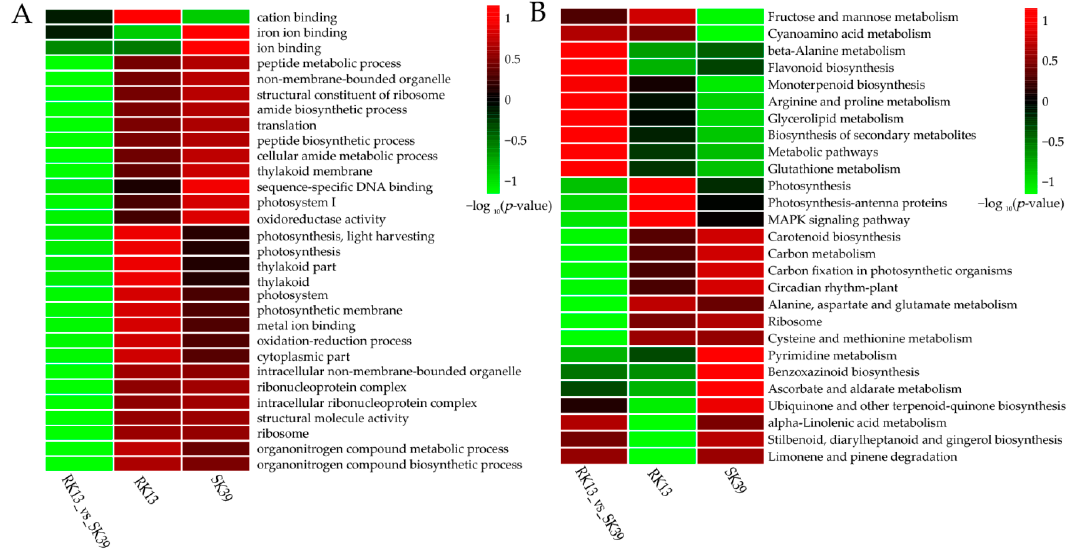
Figure 3. Functional classification of DEGs. Heatmaps of the Top 30 GO terms ( A ) and the Top 30 KEGG pathways ( B ) that were enriched in two or more comparison groups. The darker the red, the more significant; green indicates low significance.